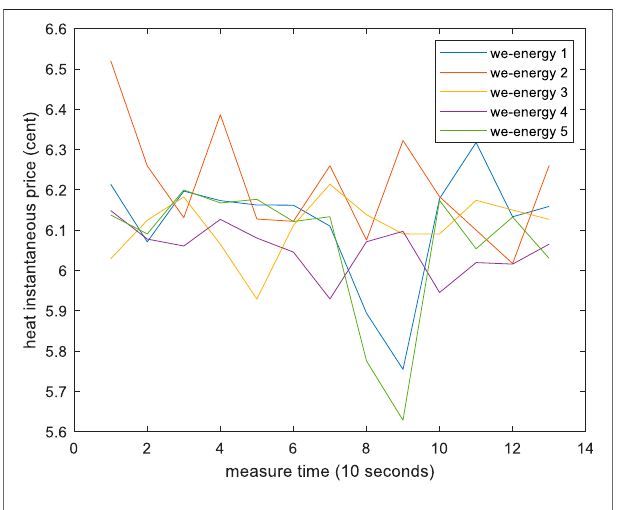
FIGURE 3 | Power instantaneous price (cent).